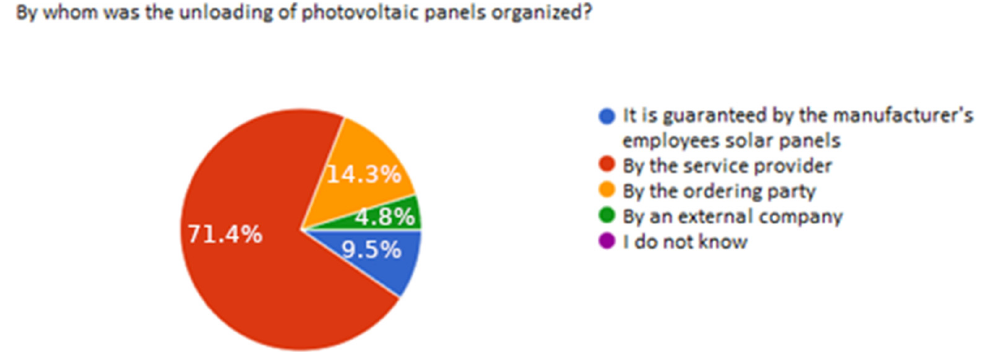
Figure 9. The unloading process.